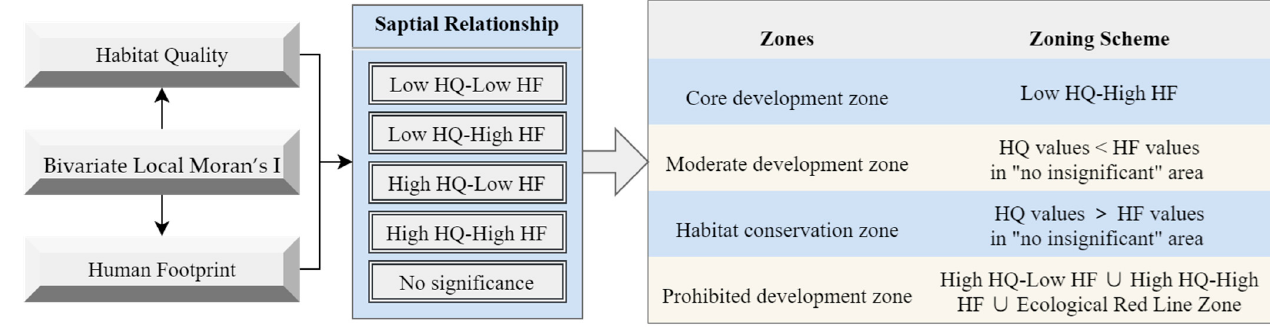
Figure 4. Spatio ‐ temporal distribution of habitat quality in Guiyang city from 2000 to 2020. The HQ of Guiyang city in 2000, 2010, and 2020 mainly concentrated on moderately high and high, with the total areas of both grades accounting for more than 60%, indicat ‐ ing that the overall ecological quality of Guiyang city was superior. The spatial distribu ‐ tions of HQ were characterized by spatial agglomeration, and the high ‐ value areas were mainly scattered at the junction of various districts and counties. Among them, the north ‐ ern regions of Guiyang city were mainly affected by the topography and location, which make the region had large areas of woodland. Moreover, the south ‐ eastern regions i.e. the south of Qingzhen and the west of Guanshanhu, had a large area with high HQ due to the impact from lakes and waters. On the contrary, the low HQ were mainly located in the southern regions, including Baiyun, Guanshanhu, Yunyan, Nanming and Huaxi, which were the core urban areas of Guiyang city and had intense effects on ecosystem. The values of HQ in Guiyang city have varied significantly from 2000 to 2020. To explore the characteristics of HQ changes in Guiyang city, origin 2021 software was used to create a chord diagram (Figure 5), which not only can clearly show the magnitude of